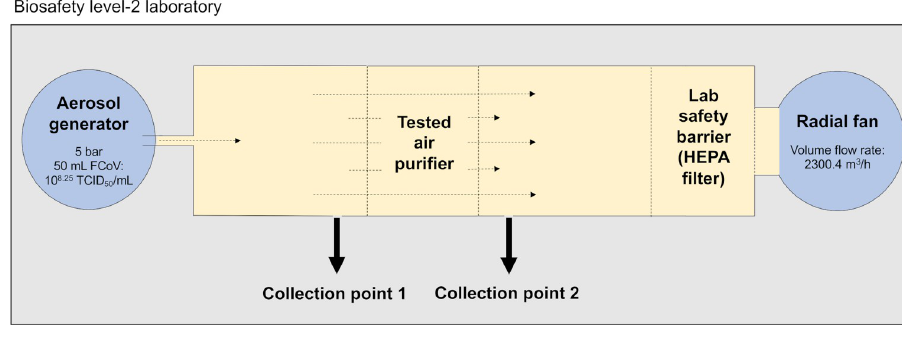
Fig 1. Air purifier testing